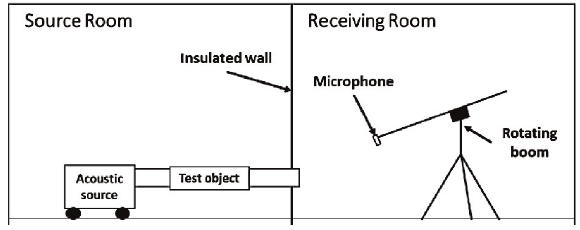
Fig. 7. Reverberation Room ʼ s test set-up at TalTech Acoustics Lab designed for the determination of acoustic insertion loss.